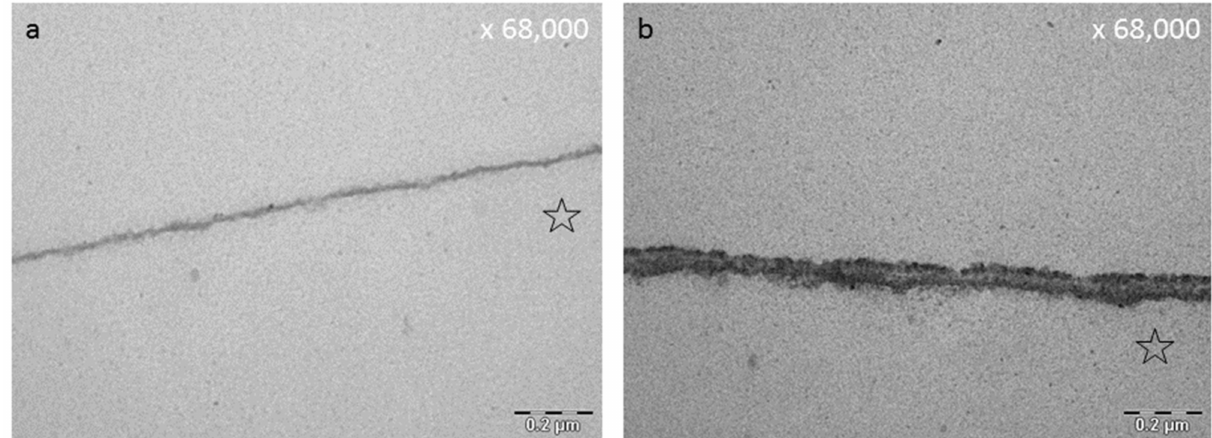
Figure 4. Effect of polyphenols on the pellicle’s ultrastructure, representative TEM images of the in situ pellicle after rinsing with tannic acid—oral exposure time 30 min: the control ( a ) shows a thin basal pellicle layer (Rehage et al. (2017) [68]; ( b ) a distinct increase in pellicle thickness and electron density after ex vivo rinsing with tannic acid (170 mg/mL, pH = 5.0). The former enamel site is marked with an